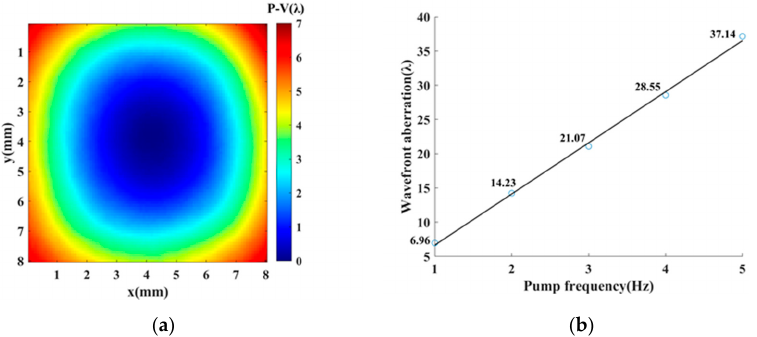
Figure 5. Peak-to-valley (P-V) wavefront distortion with fixed O-rings. ( a ) Distribution at pump frequency 1 Hz. ( b ) Graph of maximum distortion versus pump frequency.